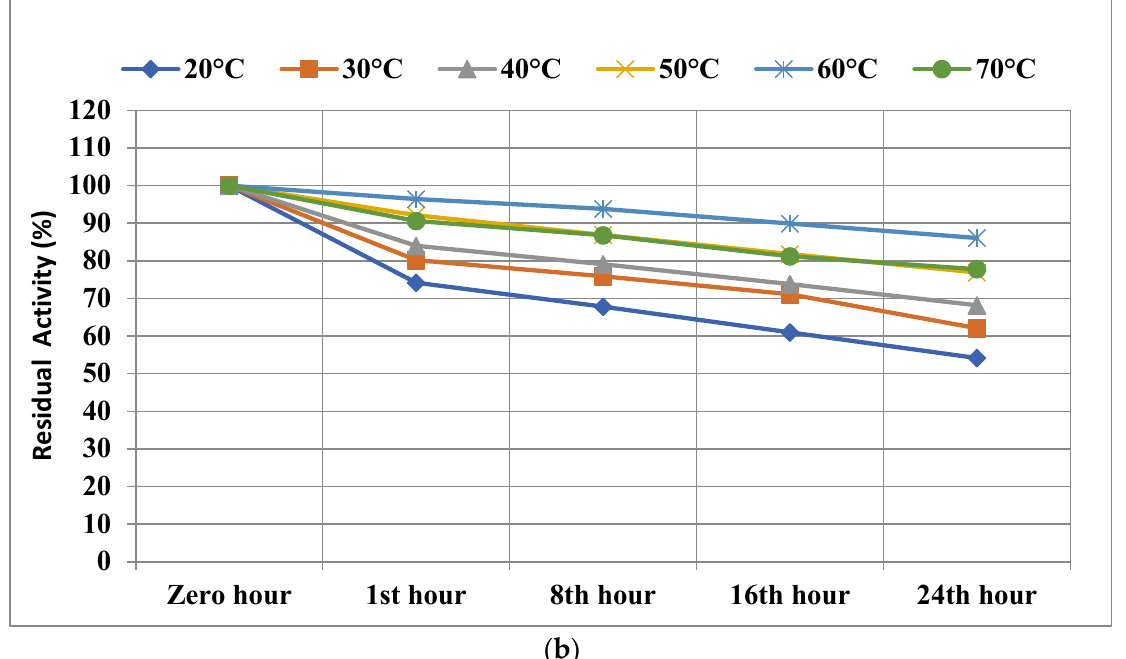
Figure 8. ( a ) Temperature stability of free MnP from A. fumigatus. ( b ) Temperature stability of immobilized MnP from A. fumigatus.